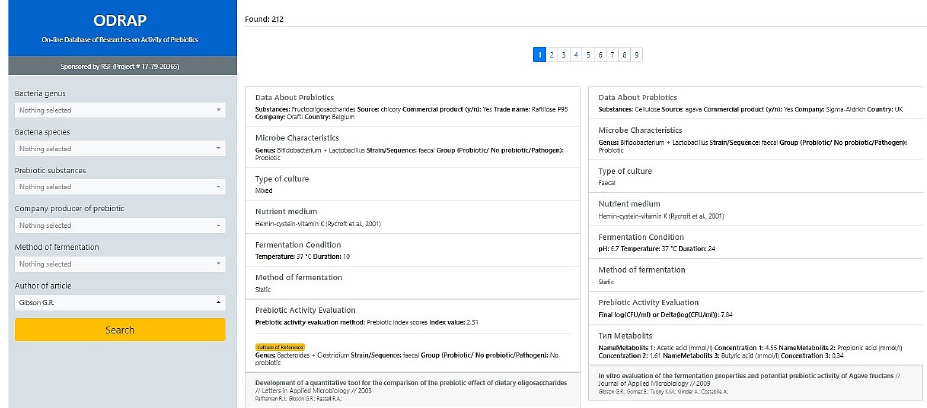
Figure 7. Example of search: the name of author of article is Gibson G.R., 212 records could be found.